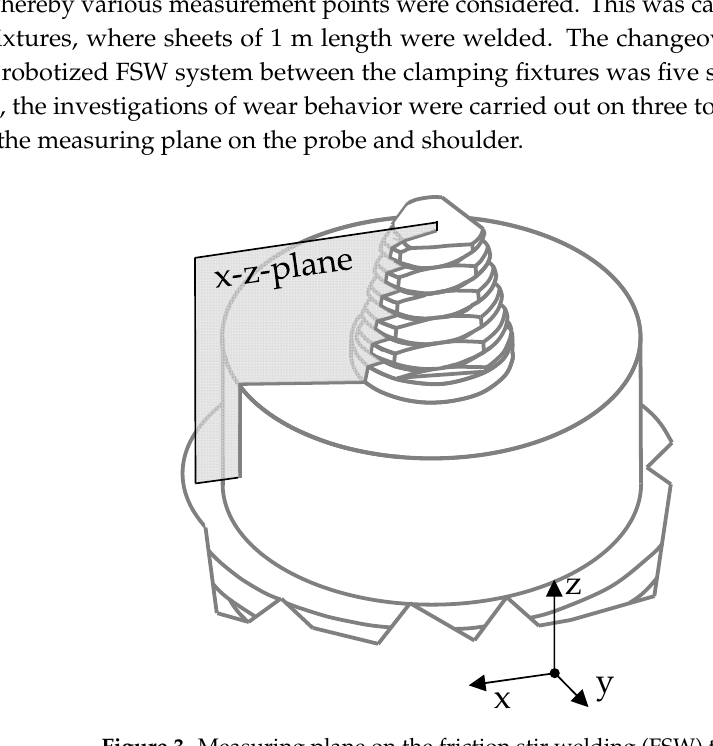
Figure 4. Measuring design with the definition of points measured on the tool.